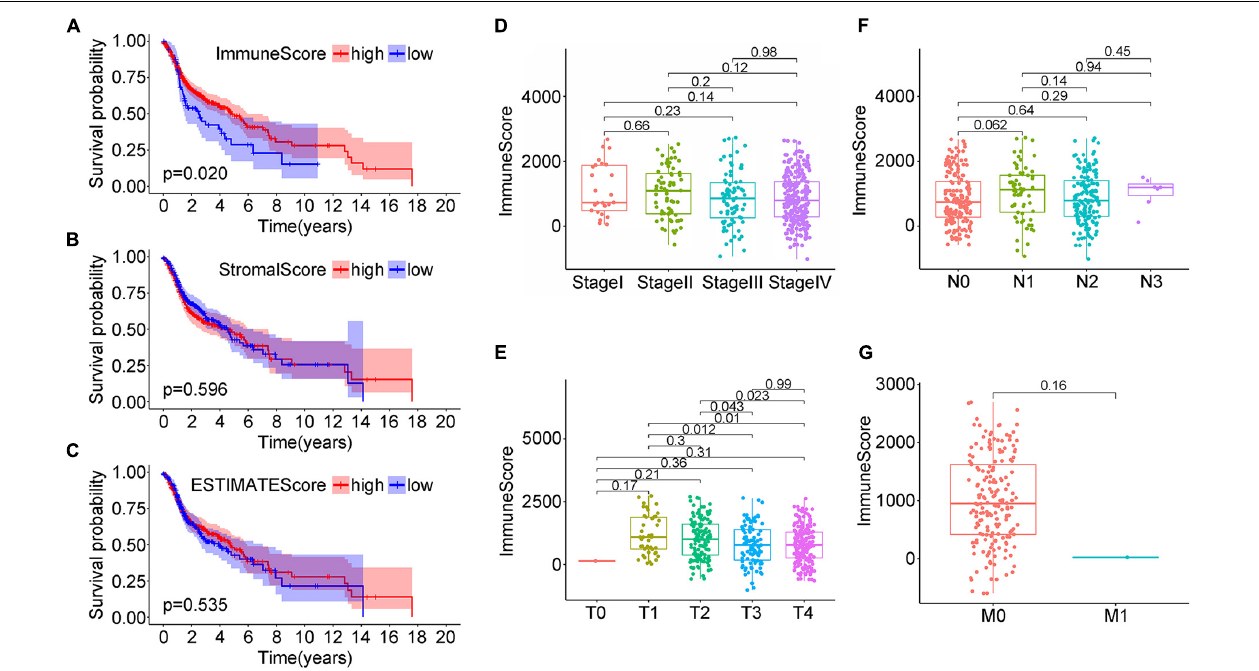
FIGURE 1 | Correlation analysis of head and neck squamous cell carcinoma (HNSC) patients survival and stromal score/immune score/estimate score distribution from the TCGA database. (A–C) Kaplan–Meier survival analysis for HNSC patients grouped by immune score, stromal score, and estimate score. (D–G) Distribution of immune score in clinical stage, T classification, N classification, and M